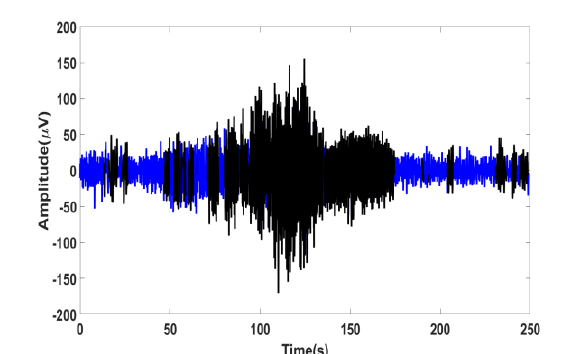
Figure 7. Graphs of the criterion   J t , its estimated value   ˆ J t , and event indicator Event obtained from active patient video record. Event is detected between 30 and 35 seconds